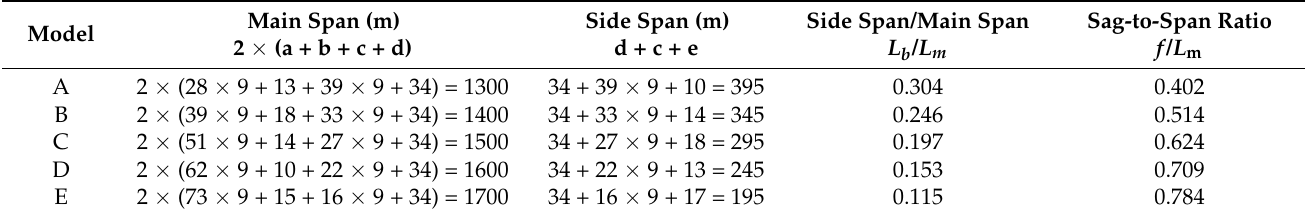
Table 2. Different dimensional